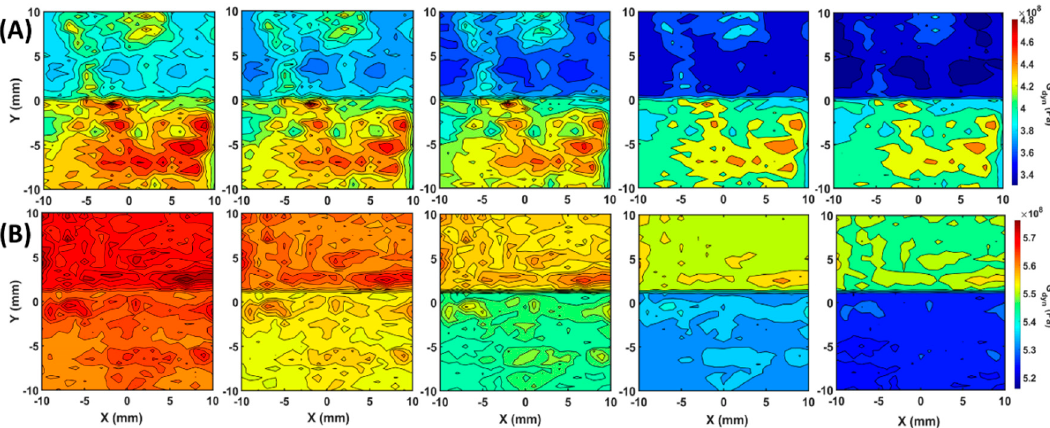
Figure 6. Angle-depedendent dynamic shear modulus distribution maps calculated by Equation (4) with ρ (cid:3032)(cid:3033)(cid:3033) and 𝐶 (cid:3021) . Row ( A ) and ( B ), from left to right, the dynamic shear modulus maps at 0°, 22.5°, ◦ , 67.5 ◦ , and 90 ◦ of sample 1 and sample 2, 45°, 67.5°, and 90° of sample 1 and sample 2, respectively. 45